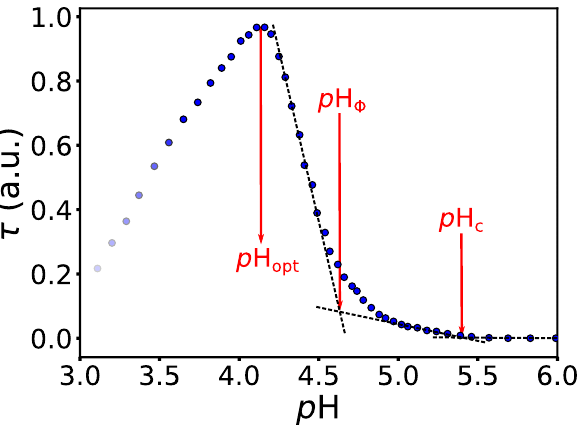
Figure 2. The turbidimetric titration curve shows the onset of formation of soluble and insoluble protein-PE complexes and their charge neutralization. Dependence of turbidity, τ , on p H for a solution containing 100 µ M BSA and 4000 µ M NaPSS dissolved in acetate buffer with initial p H = 5.8 ( I = 0.1 M) at 25 °C. The determination of the critical p H parameters corresponding to the formation of soluble ( p H c ) and insoluble protein-PE complexes ( p H Φ ) and charge neutralization of the formed complexes ( p H opt ) is schematically